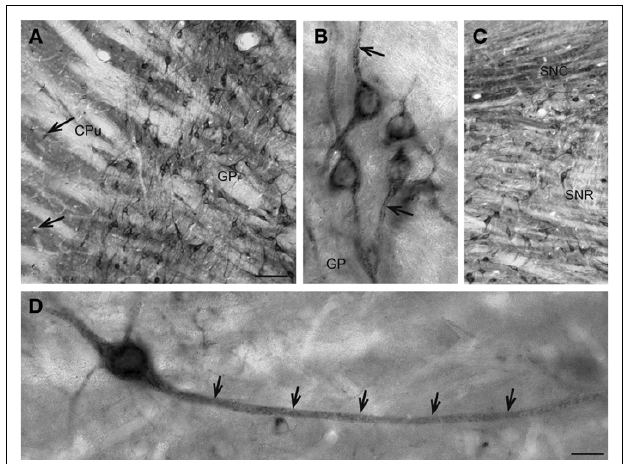
FIGURE 3 | Basal ganglionic neurons exhibit strong SAT1 immunoreactivity in their cell bodies as well as their processes. (A) Globus pallidus (GP) is highly enriched with SAT1 immunoreactive neurons. Smaller, scattered neuron-like cells strongly immunostained for SAT1 are also detected in the caudatoputamen (CPu) (arrows). (B) High power light microscopy of neurons in the globus pallidus demonstrates SAT1 immunostaining in the cell bodies as well as in their processes. Note that the immunostaining is restricted to the plasma membrane (arrow). (C) In the reticular part of substantia nigra (SNR), neuronal cell bodies and their processes are strongly immunolabeled for SAT1. The compact part of the substantia nigra (SNC) shows SAT1 immunostaining diffusely in the neuropil and in some smaller cell bodies. (D) A neuron-like cell is stained for SAT1 in the caudatoputamen. Note that the staining appears in the cell body and its processes (arrows). CPu, caudatoputamen; GP, globus pallidus; SNC, substantia nigra pars compacta; SNR, substantia nigra pars reticulata. Scale bars: 20 µm (B,D) , 80 µm (A,C) .